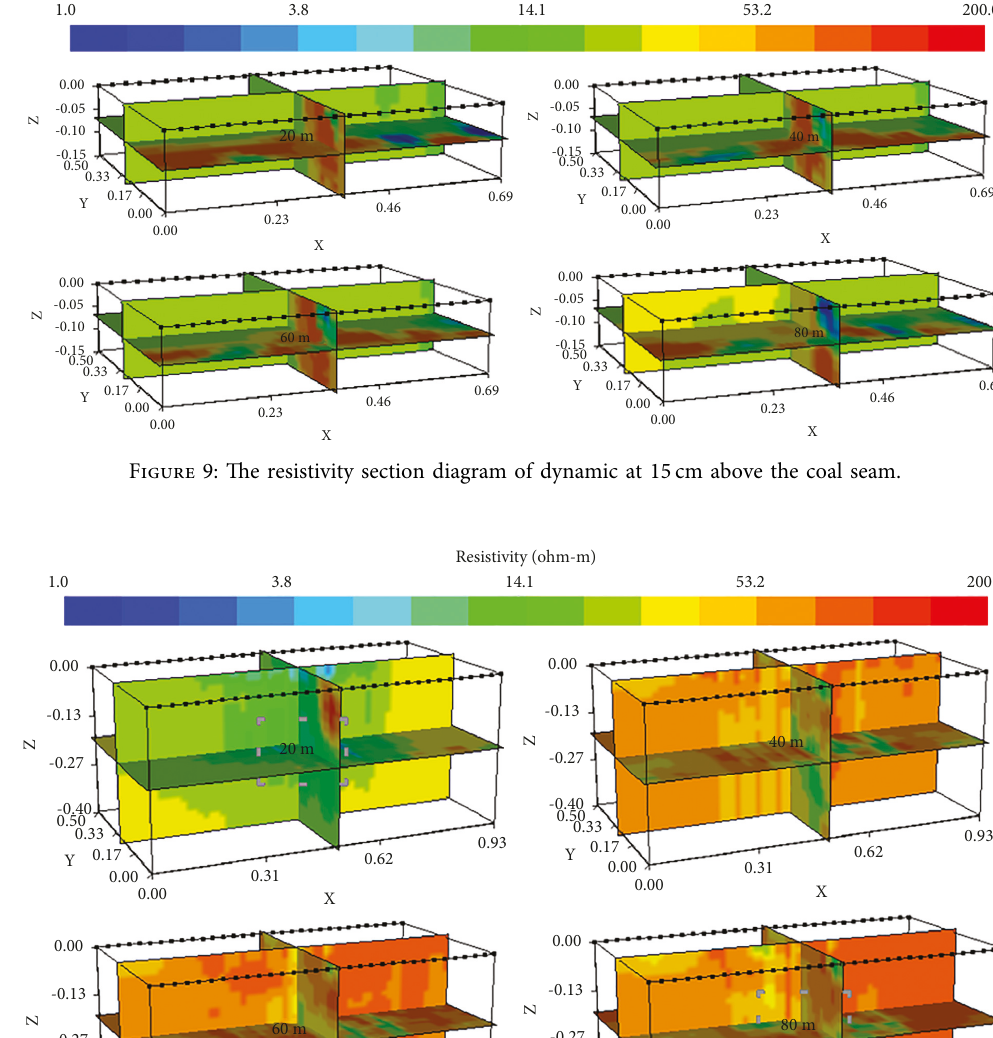
Figure 10: The resistivity section diagram of dynamic at 40cm above the coal